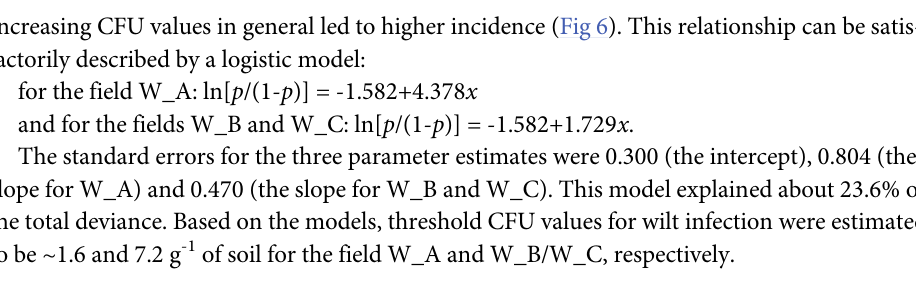
Table 1). About 56% of plants in X_A had wilt scores of at least 3, compared to 5% in X_B and 0.4% in X_C. Within-row join-count statistics (DD) were significantly greater than the expected under the assumption of a random pattern for lag 1 – 3 (0.1 – 0.3 m, P < 0.01) and lag 4 (0.4 m, P < 0.05) for X_A (Table 2). For X_B, within-row join-count statistics were significant